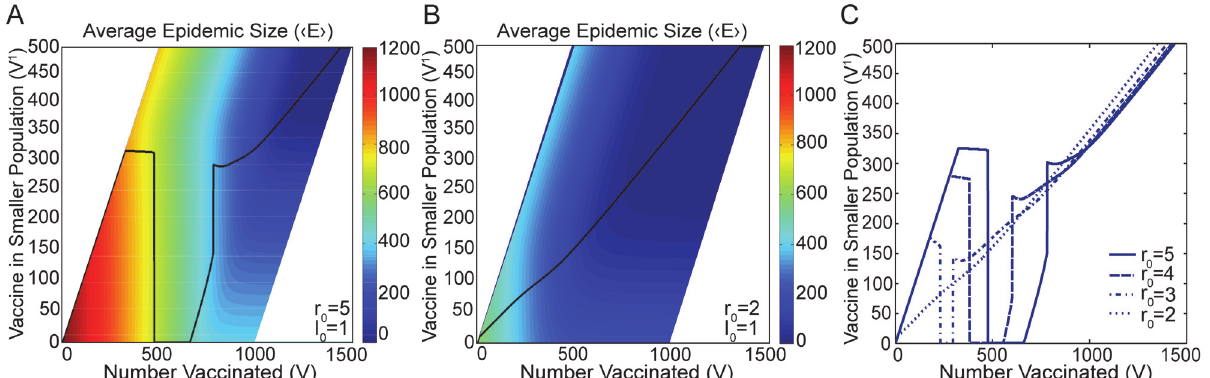
Fig 4. Optimal Solution in the Stochastic Model. The black lines of Figures A and B illustrate the optimal allocation of an amount of vaccine V that minimizes h E i for, respectively, r 0 = 5 and r 0 = 2. The y-axis here shows the amount of vaccine allocated to the smaller population V 1 . The color scale indicates the average epidemic size h E i corresponding to a particular allocation of vaccine. Figure C shows how the optimal solution varies as r 0 changes from 2 to 5. Switching behavior vanishes when r 0 (cid:7) 2.9 (not shown). Results are obtained for two populations of sizes N 1 = 500 and N 2 = 1000. Both ¼ I 2 ¼ populations are initialized with a single infected individual I 1 0 0